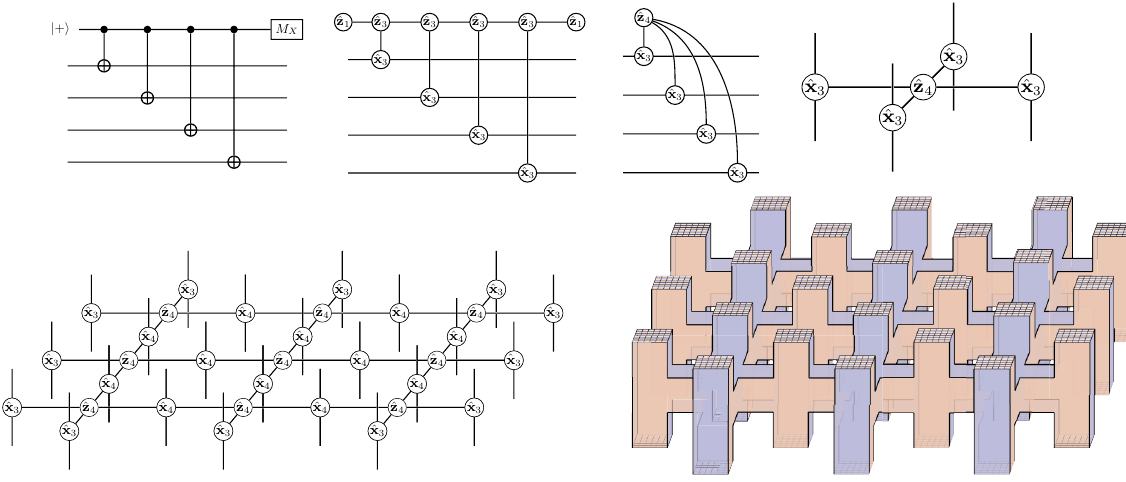
FIG. 24. Converting a Clifford circuit to a spider network. Top: the CNOT gates, |+(cid:3) preparation, and M X measurement operations can be represented by the spiders ˆ x k and ˆ z k as shown. One can simplify the spider operations by merging them as shown, giving the minimal network on the right. For the first three figures, time moves from left to right, whereas for the rightmost figure, time moves from bottom to top. Bottom: measuring stabilizers of a (Kitaev) surface code concatenated with itself. Time moves from bottom to top. On the left, we depict a network of ˆ x 4 and ˆ z k spiders to implement a round of X ⊗ 4 surface code stabilizers. On the right, we depict the corresponding network of logical blocks. To obtain the measurement pattern of the Z ⊗ 4 surface code stabilizers, one can swap the role of the ˆ x 4 and ˆ z k